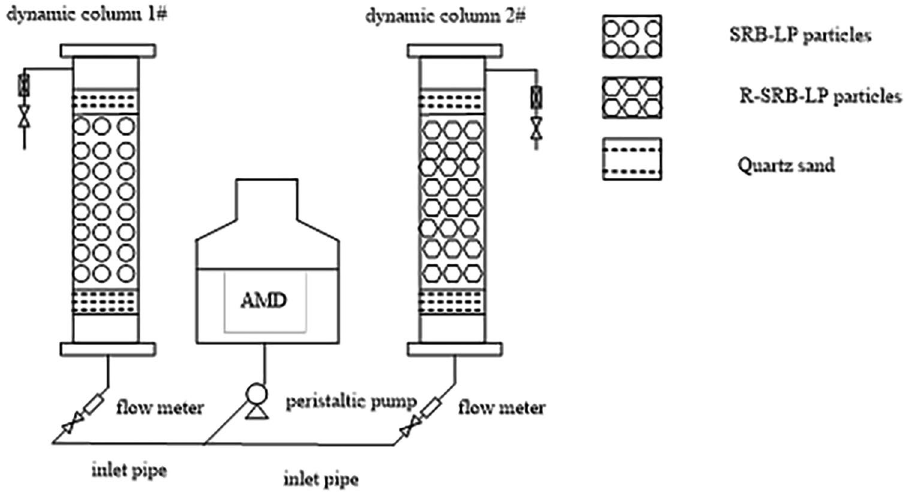
Figure 1. Experimental